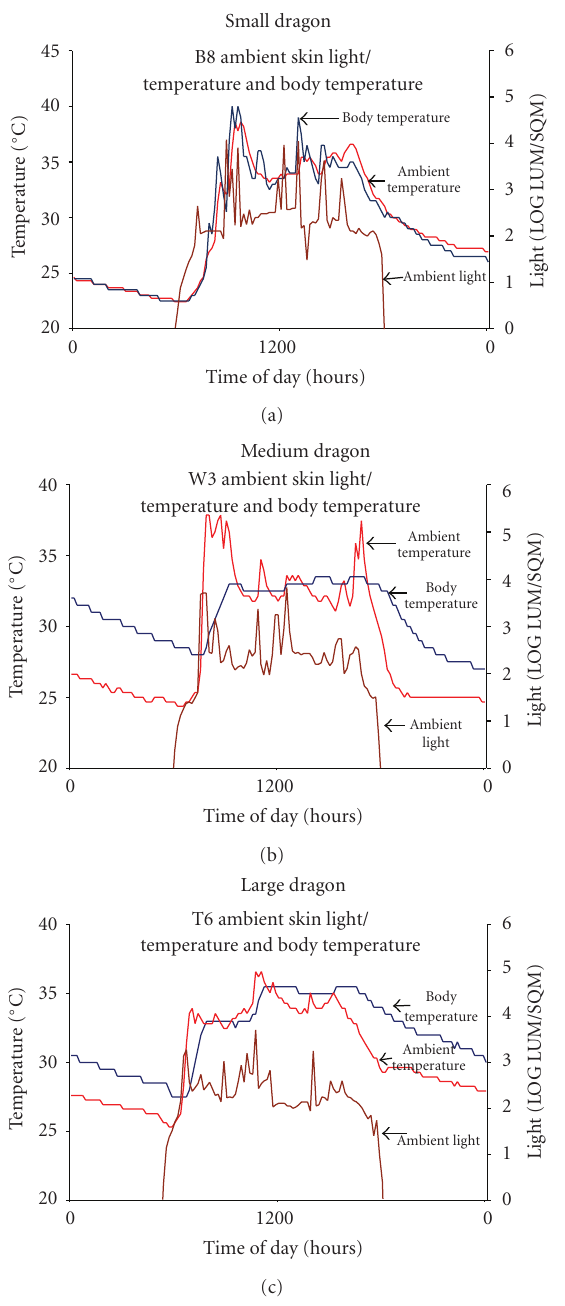
Figure 1: Daily body temperature and ambient light and temper- ature exposure by a representative (a) small (5.6 kg), (b) medium (25kg), and (c) large (70kg) Komodo dragon. Abrupt changes of over 0 . 5 ◦ C or 0.1 log Lum/m 2 represent temperature and light spikes, respectively.